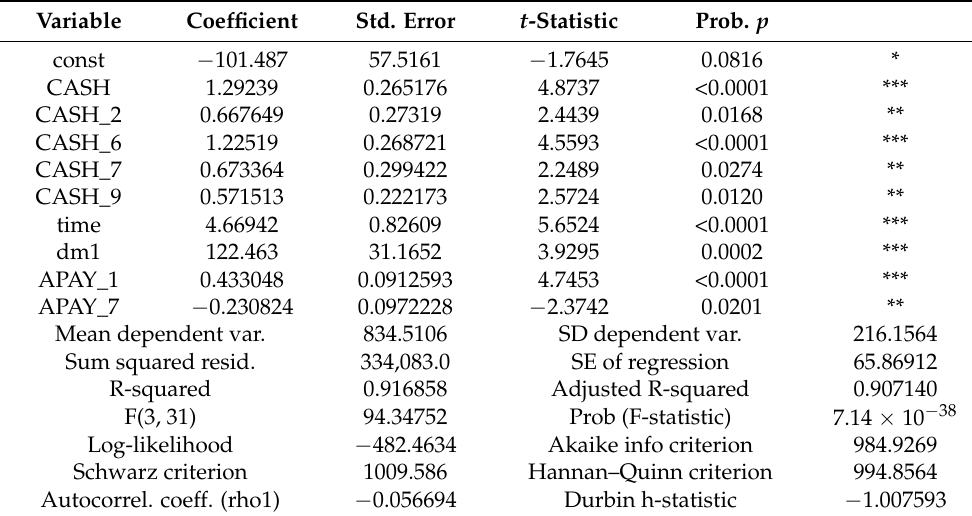
Table A5. Dependent variable: average net wage in the enterprise, paid to employees for work in period t (APAY) (observation 2001:01–2007:12 (N =